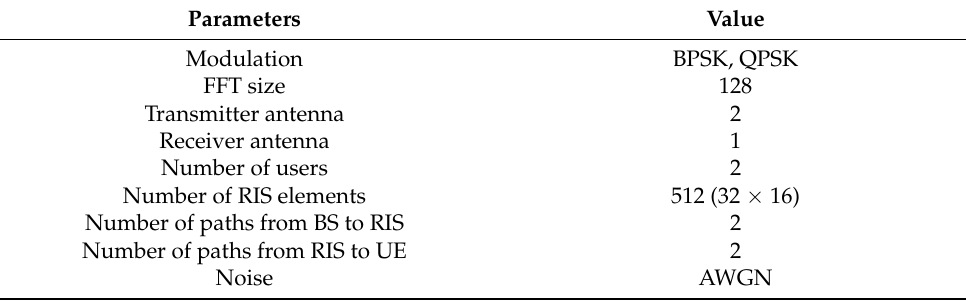
Table 1. Dataset generation